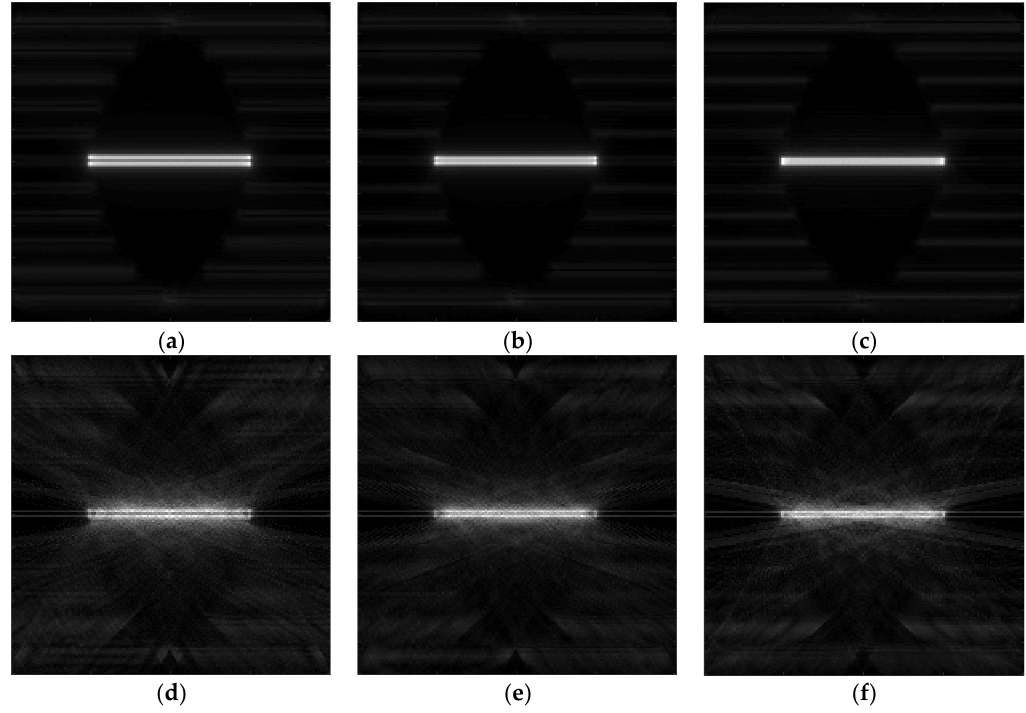
Figure 6. Double-line target imaging with a synthetic aperture of 5°. The piecewise linear transformation parameters are T = 0.95, k 1 = 1.2, k 2 = 0.1: ( a , d ) The distance between the two lines is 0.4; ( b , e ) The distance between the two lines is 0.3; ( c , f ) The distance between the two lines is 0.2. Figure 7a–c is the imaging result of traditional backprojection algorithm with full synthetic aperture when two lines are 0.4, 0.3 and 0.2 apart. Figure 7d–f corresponds to Figure 7a–c imaging . As can be seen results of full aperture after piecewise linear transformation at each slow time n from Figure 7, the two lines can be distinguished from the imaging results after piecewise linear transformation in three cases, while the traditional backprojection algorithm cannot distinguish the two lines when the distance is less than 0.2.